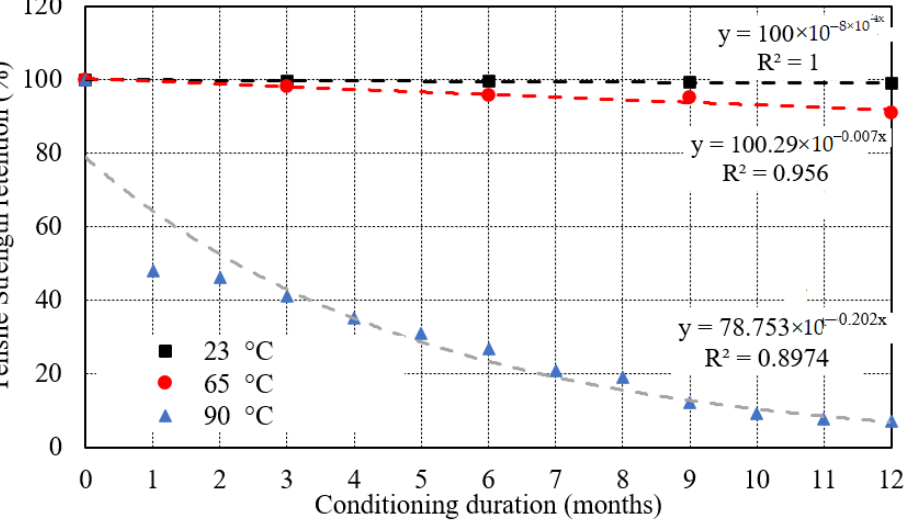
Figure 13. Tensile strength retention of E-glass epoxy samples exposed to seawater at 23 ◦ C, 65 ◦ C, and 90 ◦ C. A different approach based on a time-shift factor (TSF) was used by Dejke [49]. The time-shift is defined as the ratio of times (t 1 and t 2 ) required to determine a certain level of decrease in the mechanical property at two different temperatures (T 1 and T 2 ). According to Equation (7), the time required to obtain a certain level of decrease in mechanical property is the inverse proportion of the reaction rate K.